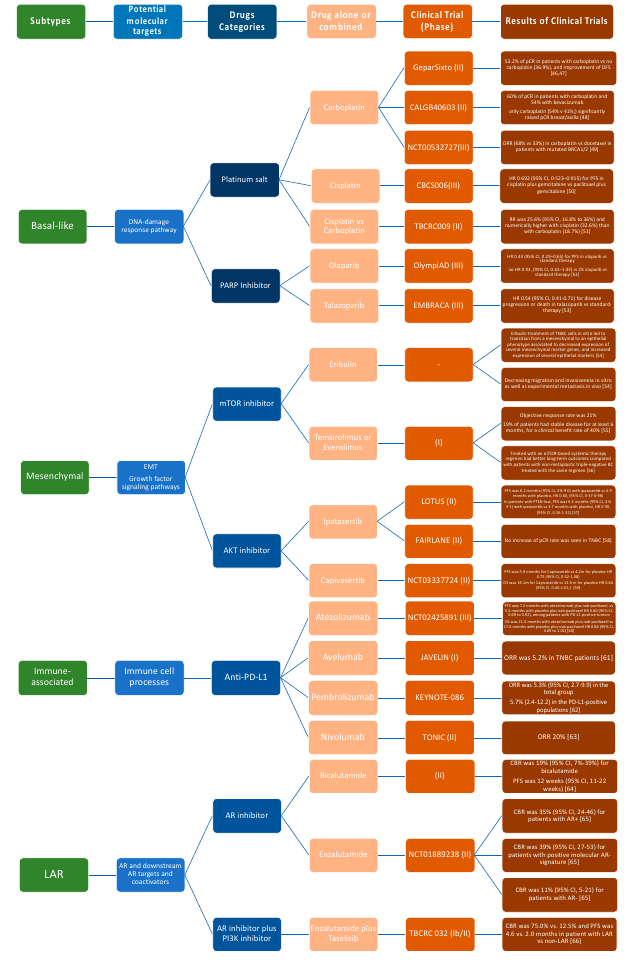
Figure 2. Current advances in systematic treatment for patients affected by different TNBC subtypes